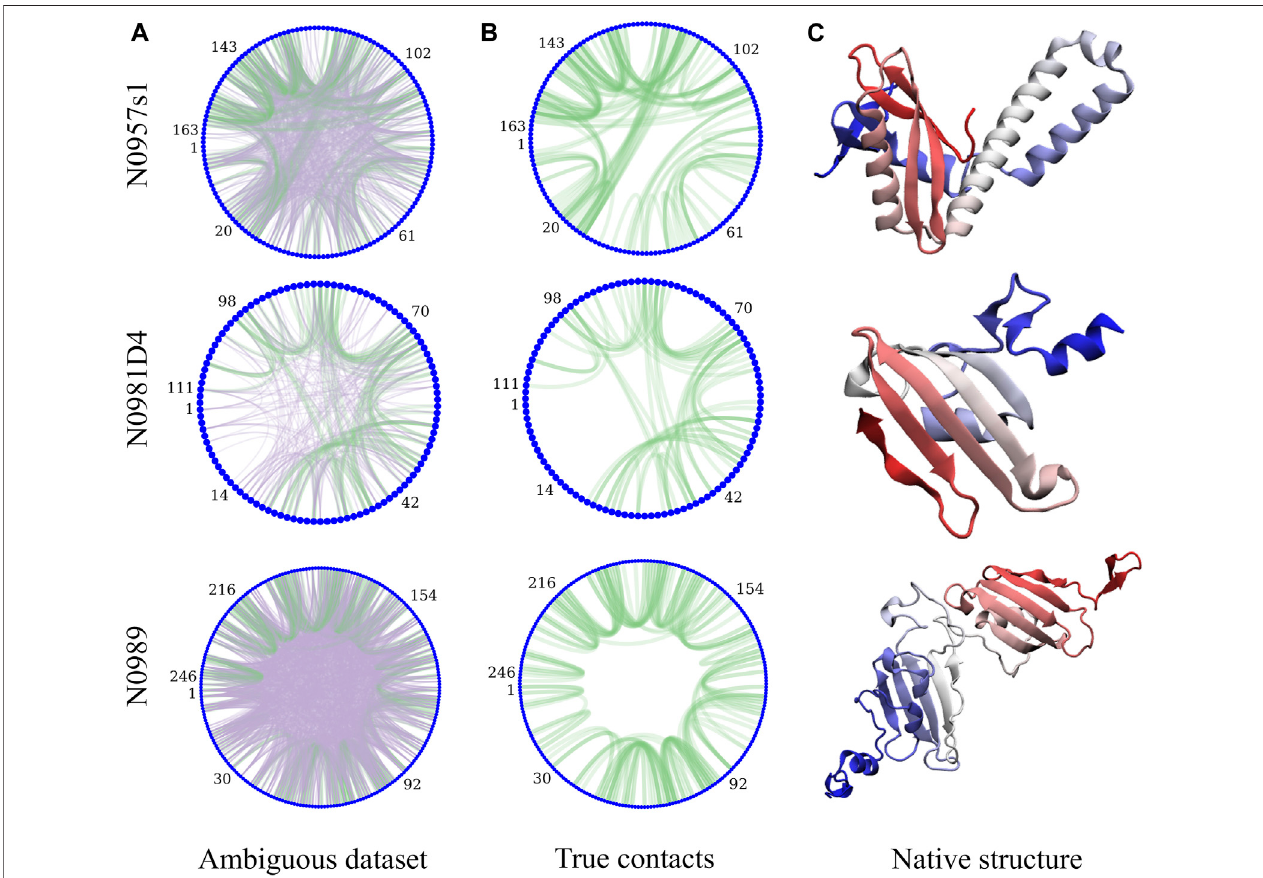
FIGURE 1 | Protein topology determines the heterogeneity in the NMR datasets and their information content. The circle plots are a graph representation of the protein sequence, with each residue being a blue node. Lines represent contacts present in the dataset due to ambiguity (A) . Purple lines represent incorrect assignmentsofthepeaks and greenarethe correctassignments. (B) showsonly thecorrect assignments for clarity. (C) showsthe experimental structures(N-termini in blue and C-termini in red).